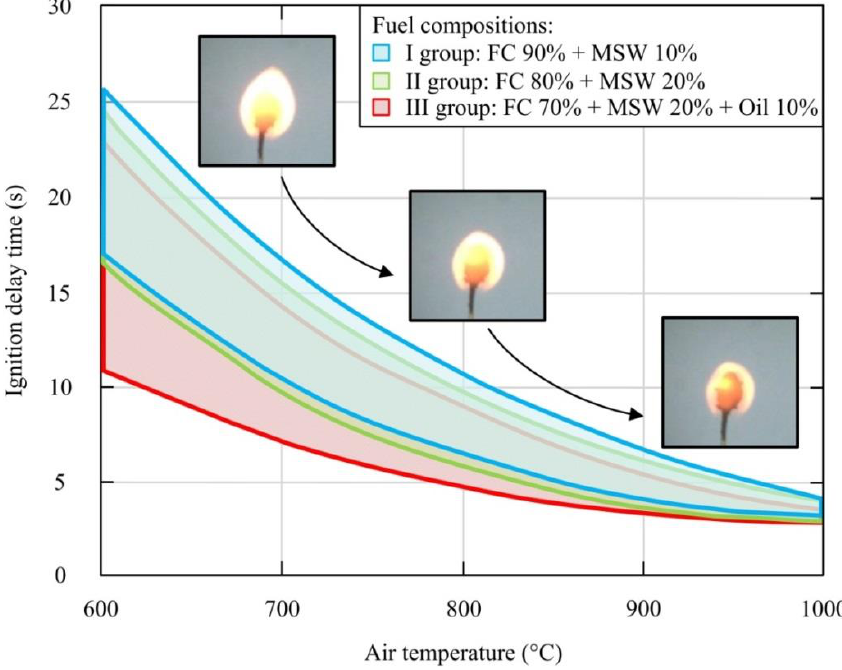
Figure 3. Regions of ignition delay times (highlighted in color) for composite fuels. Table 5. Ignition delay times (s) of composite